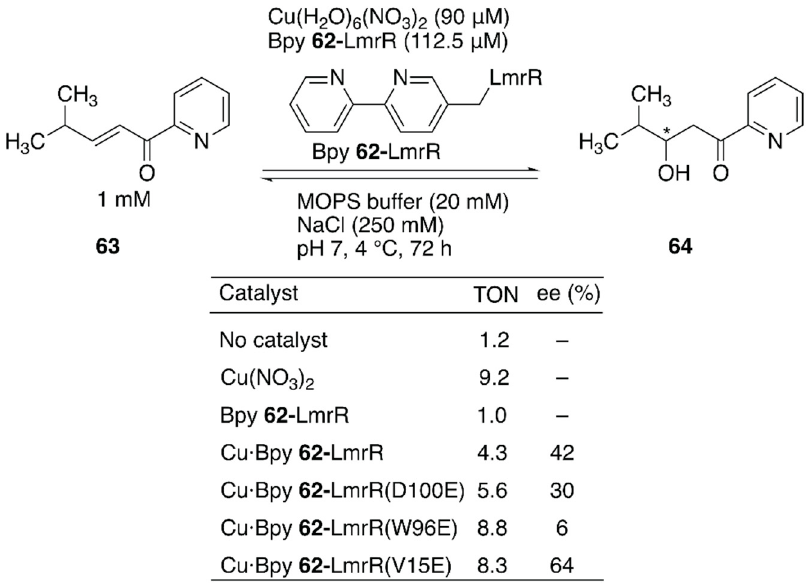
Figure 12. Enantioselective hydration reaction catalyzed by Cu · Bpy 62 -LmrR. Adapted from [91]. See Figure 7 for the crystal structure of LmrR.